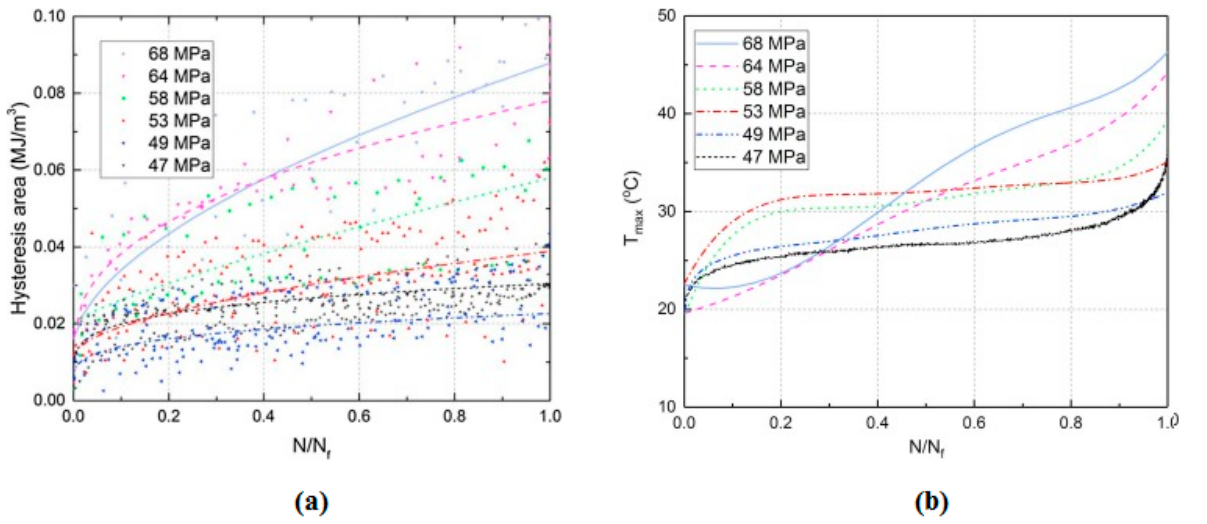
Figure 19. ( a ) Alteration of hysteresis area and ( b ) variation of maximum self-heating temperature as the function of applied stress level and cycle ratio ( N / N f ), adapted with permission from Ref. [77]. Copyright © 2018 Elsevier